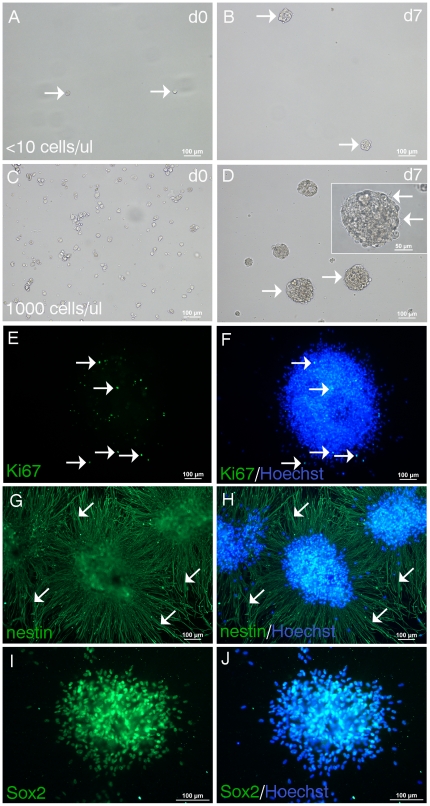
Neurospheres form at clonal density and express stem cell markers.NPSC cultured as an adherent monolayer for 39div were seeded at clonal density (<10 cells/µl) in EGF/FGF2 medium in suspension culture. A, Image taken on the day of seeding (d0) show single cells (arrows). B, 7d later neurospheres have formed (arrows). C, NSPC seeded at higher density (1000 cells/µl) at the time of plating form more neurospheres which are larger (arrows) (D, at 7d). Inset in D shows a high magnification image of a single neurosphere with a phase bright profile and ciliary projections (arrows). Neurospheres were plated onto matrigel and immunostained with stem cell markers. E-F, A single neurosphere showing proliferating Ki67+ NSPC (arrows) (E, green) stained with the nuclear dye Hoechst (F, merged). G-H, Three adjacent neurospheres expressing high levels of nestin (G, green) with nestin+ processes radially emanating from the neurospheres (arrows) (H, merged). I-J, Most NSPC comprising the neurosphere express Sox2 (I, green; J, merged with Hoechst nuclear counterstain).